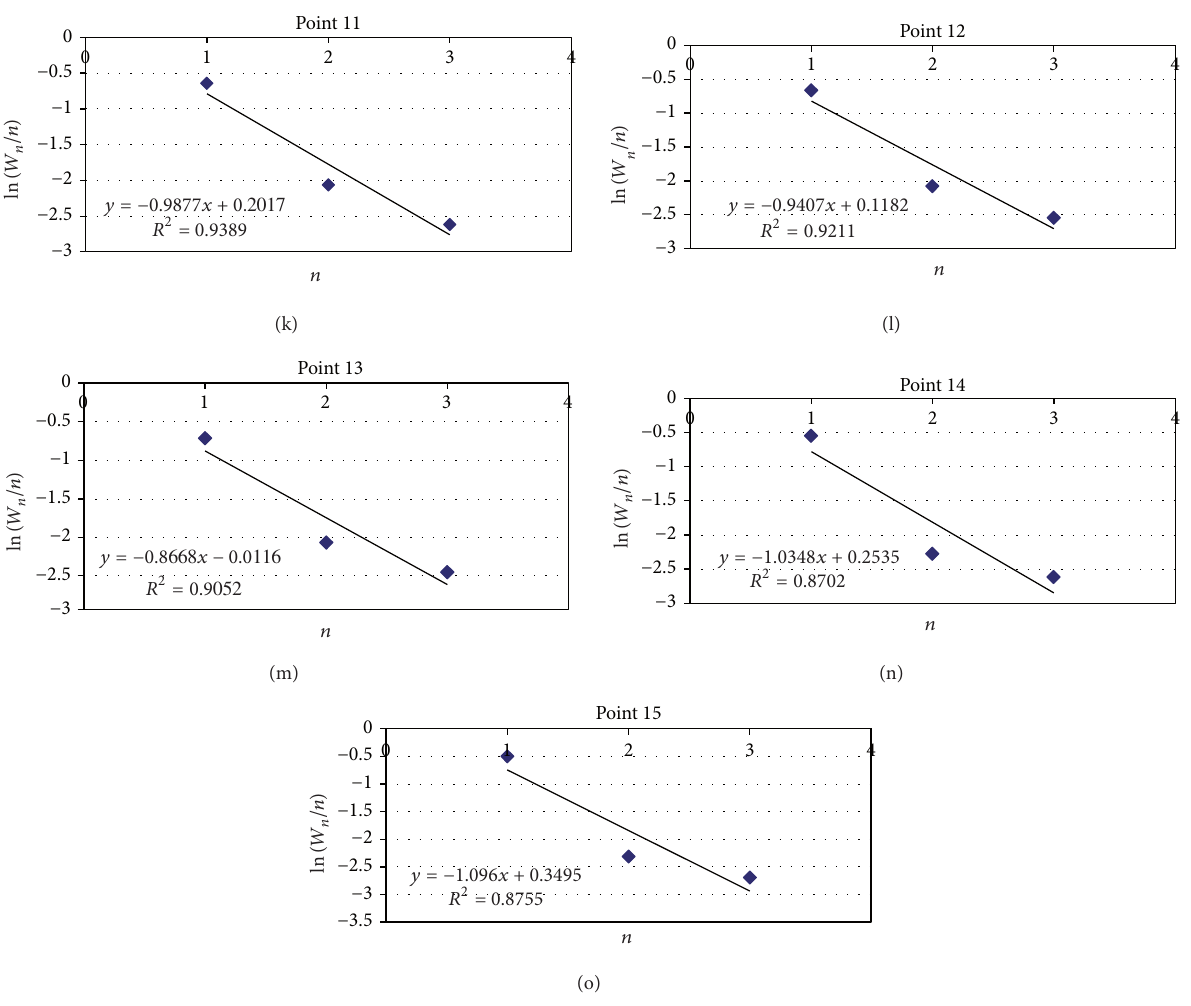
F 7: Distribution of products according to the ASF